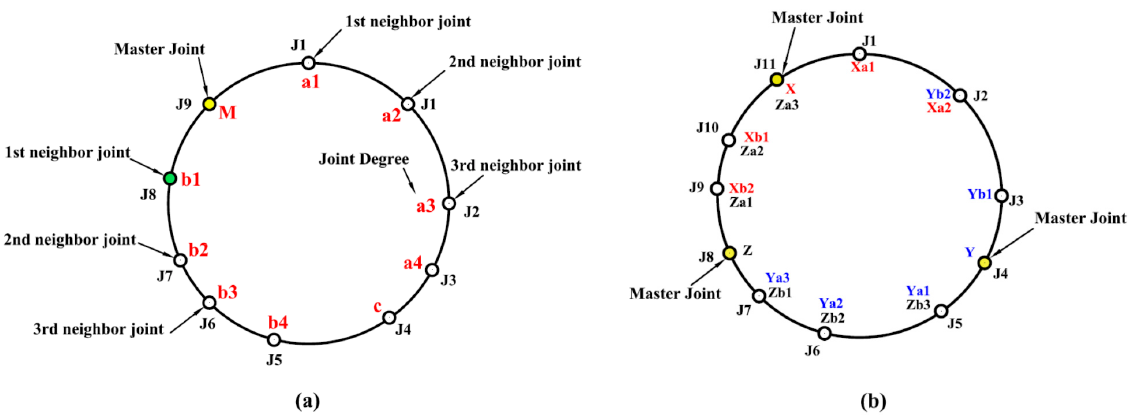
Figure 8. General schematic diagram for a given loop has ( a ) a single master joint and ( b ) multiple master joints. Algorithm 1 . Code structure for determining the unified loop array, ULA, for single master joints.